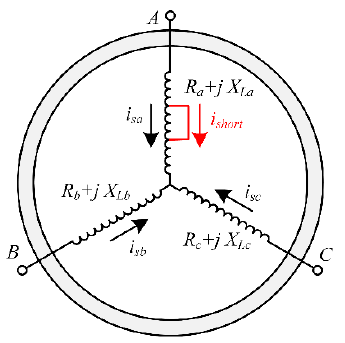
Figure 1. Schematic diagram of stator interturn short-circuit fault.